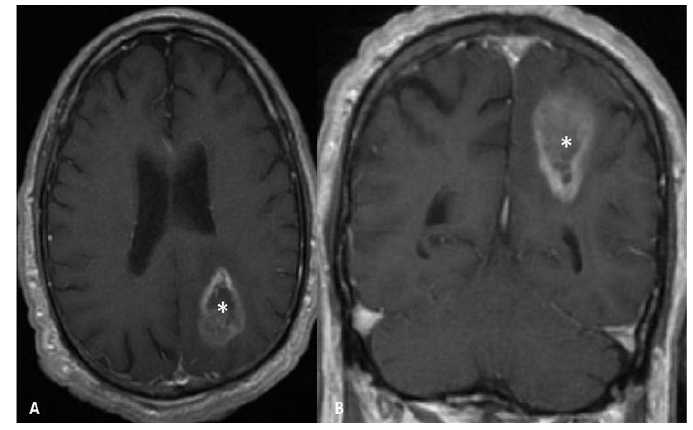
Figure 2. No Evidence of Ependymal Enhancement on MRI (Group B). Axial (A) and coronal (B) gadolinium-enhanced T1-weighted images showing a left parietal ring enhancing lesion not contacting the ventricular